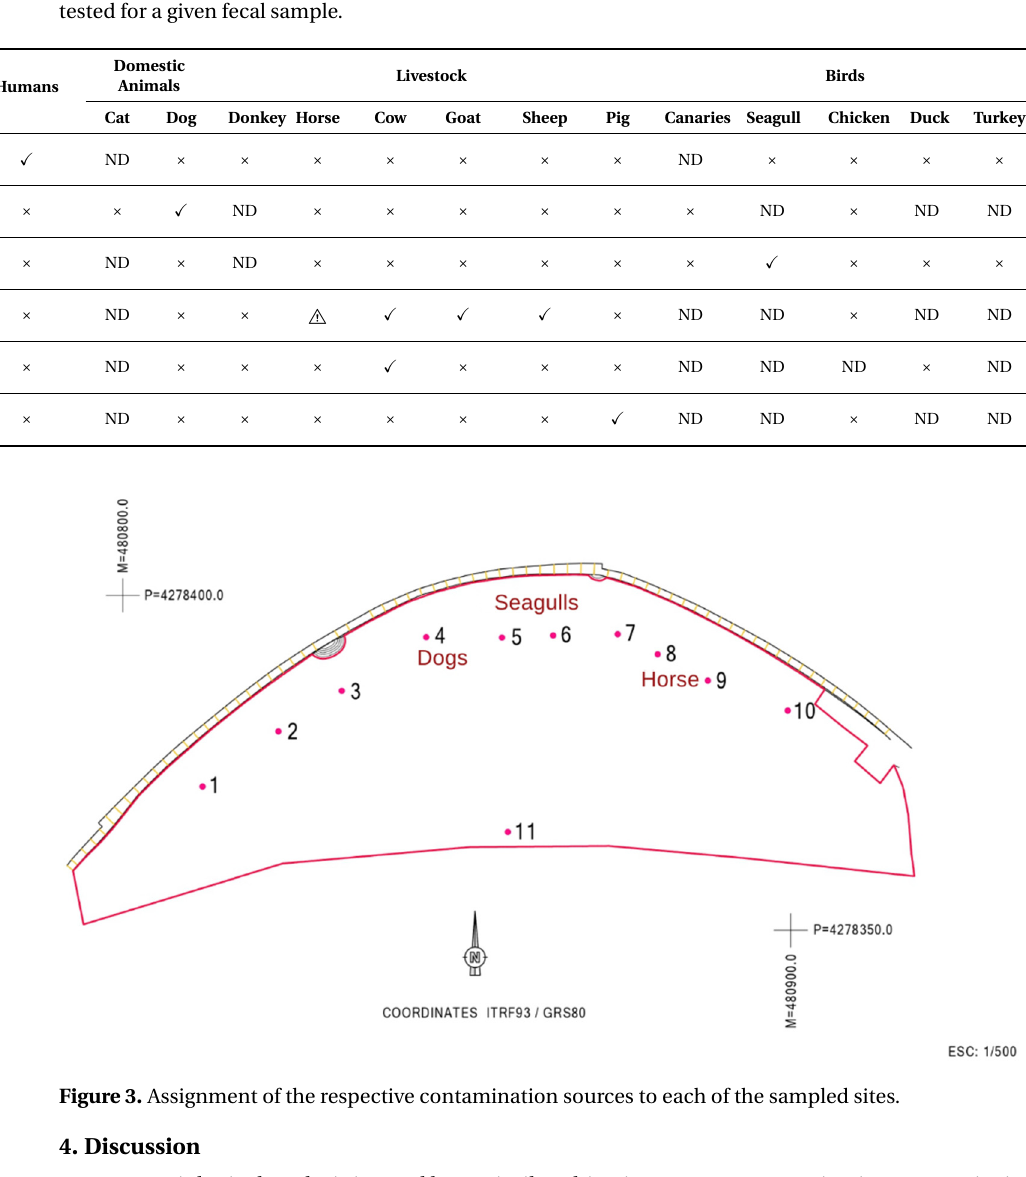
Table 3. Summarized table of the amplifications associated with each molecular marker selected. Repre- sented with “ (cid:88) ” are the samples that, when amplified by the marker, presented a band in the region of interest, and represented with “ × ” are those that did not present bands in that region. ND—not determined for the primers. The symbol “ (cid:34) ” indicates that there was evidence of cross-reactivity when the marker was tested for a given fecal sample.